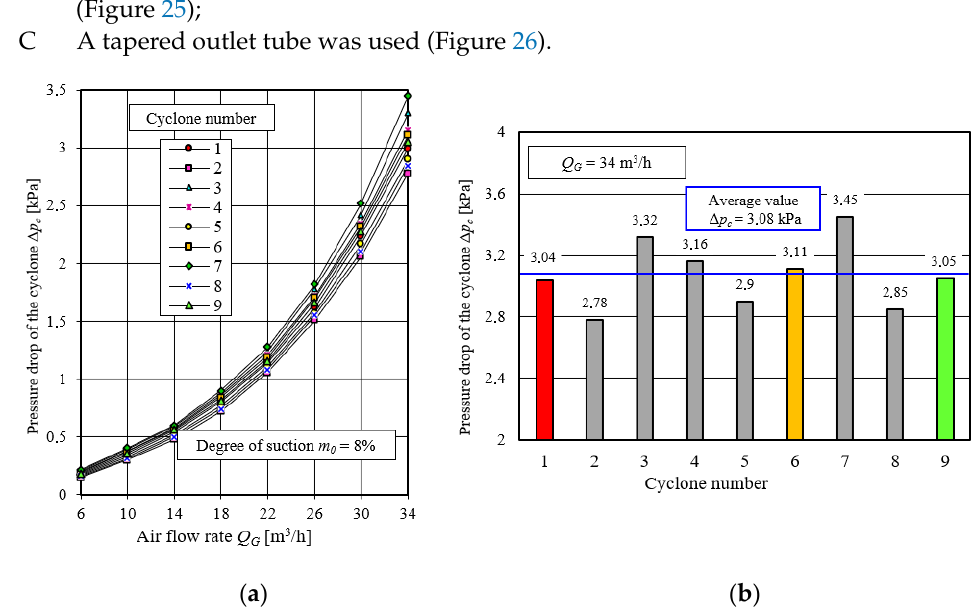
Figure 25. Preliminary test results of tracked vehicle air filter cyclones: ( a ) cyclone flow characteristics and ( b ) nominal cyclone pressure drop values.